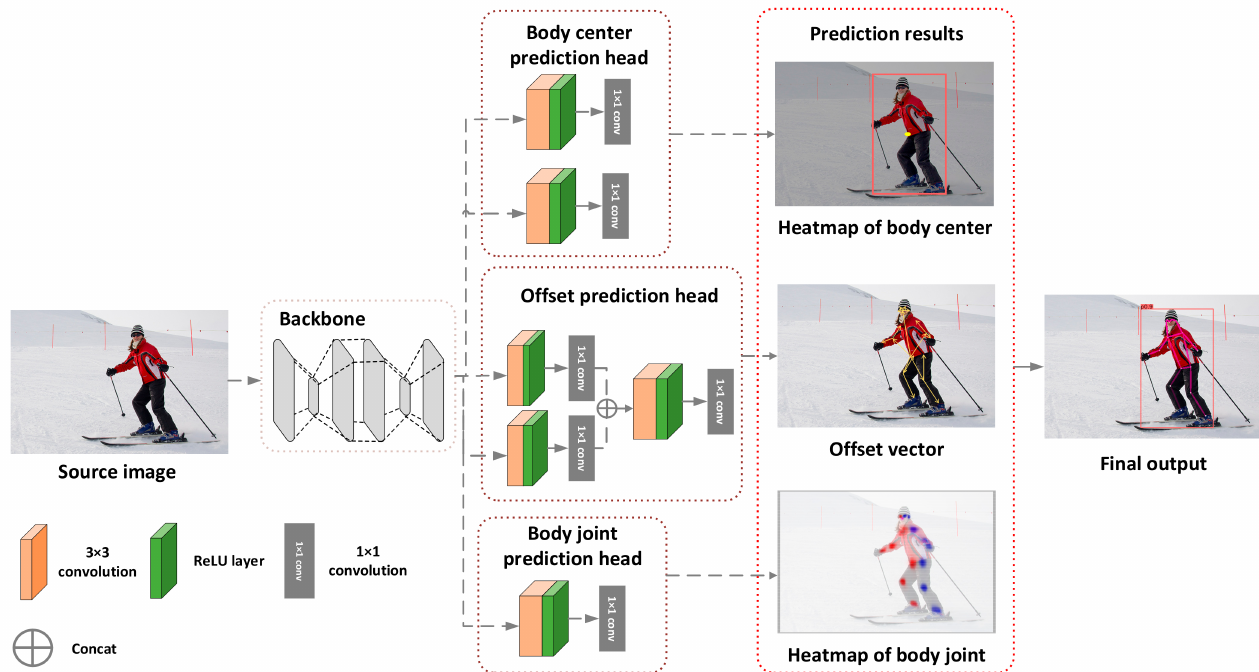
Figure 3. The architecture of the Partitioned CenterPose Network. A convolutional backbone network applies three sets of prediction heads to predict instance location, joint offset, and joint heatmap. The final output is generated by combining these three prediction